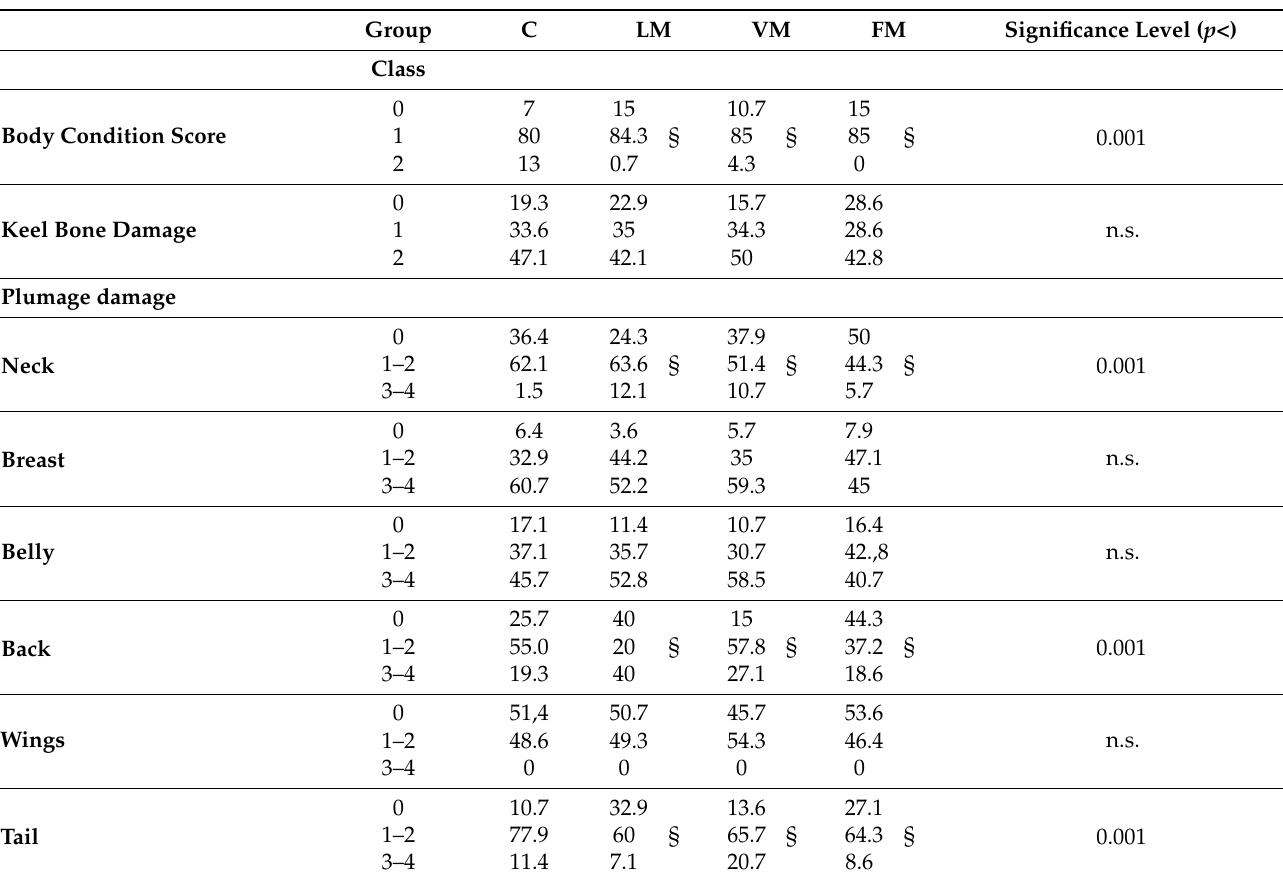
Table 2. Class distribution (expressed as a percentage) of the welfare parameters assessed at the end of the trial (78 weeks of age) (C = Control, LM = Longitudinal Movement, VM = Vertical Movement, FM = Freedom of Movement). For plumage damage, classes 1–2 (mild damage) and 3–4 (severe damage) were aggregated. The symbol § close to the class distribution percentages indicates significant differences with the control group. Group C LM VM FM Significance Level ( p <)